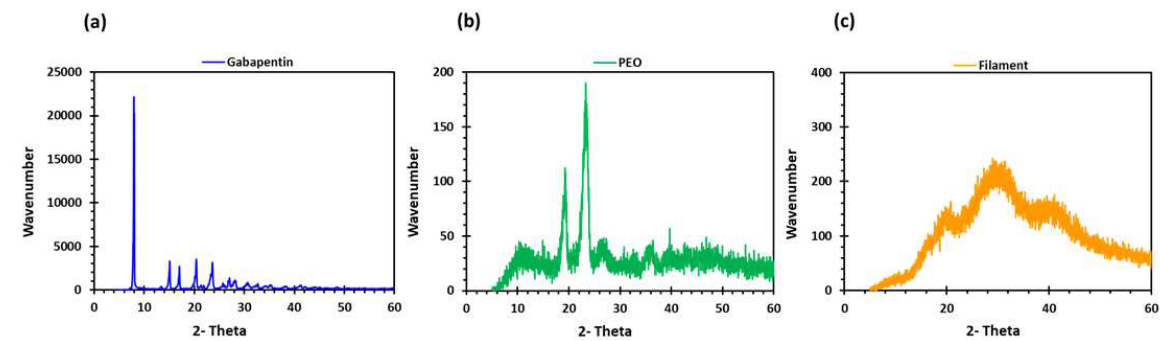
Figure 3. TGA profiles of ( a ) gabapentin; ( b ) polyethylene oxide (PEO); and ( c ) GBP/PEO filament.